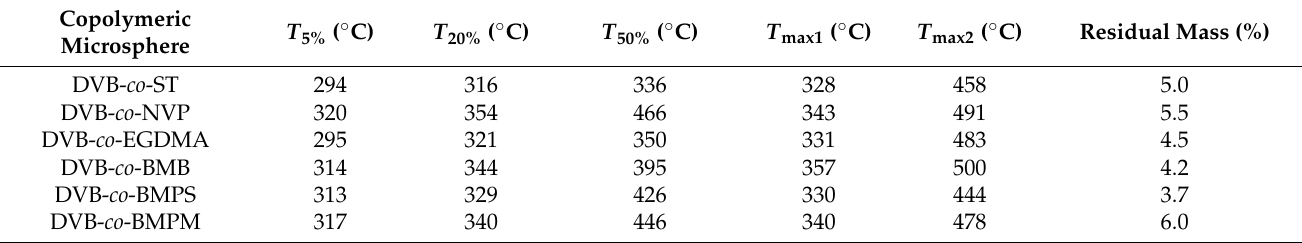
Table 5. TG and DTG data of the copolymeric microspheres obtained in synthetic air atmosphere.